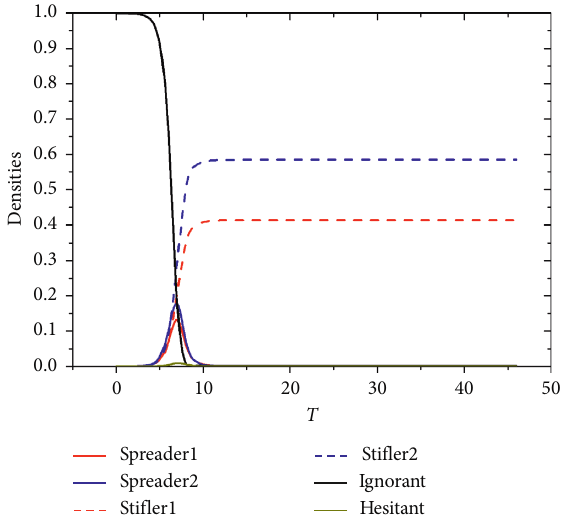
Figure 2: Density of 6 categories of people in homogeneous network.